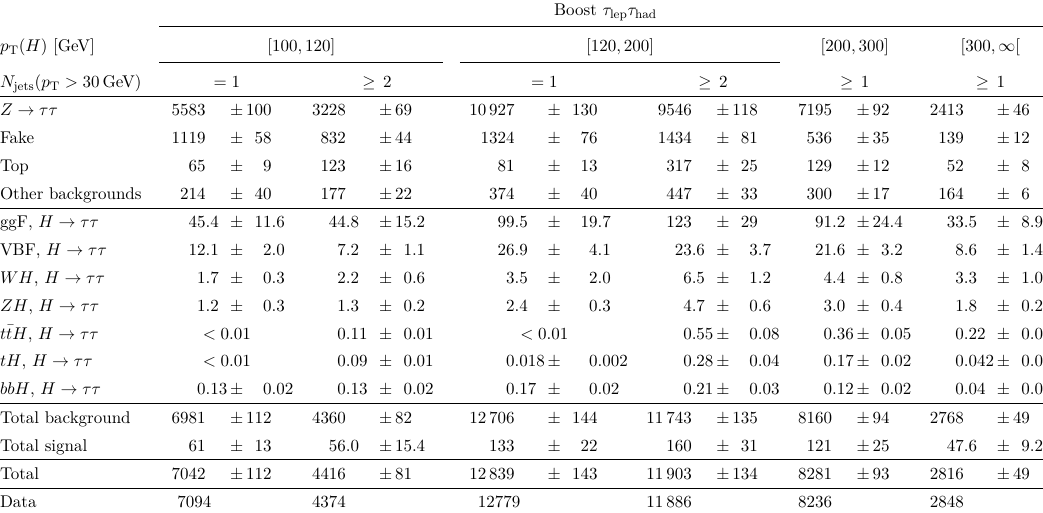
Table 12. Observed event yields and predictions as computed by the fit in the boost signal regions of the τ τ channel. Uncertainties include statistical and systematic components. The prediction lep had for each sample is determined from the likelihood fit performed to measure the pp → H → ττ cross-section.